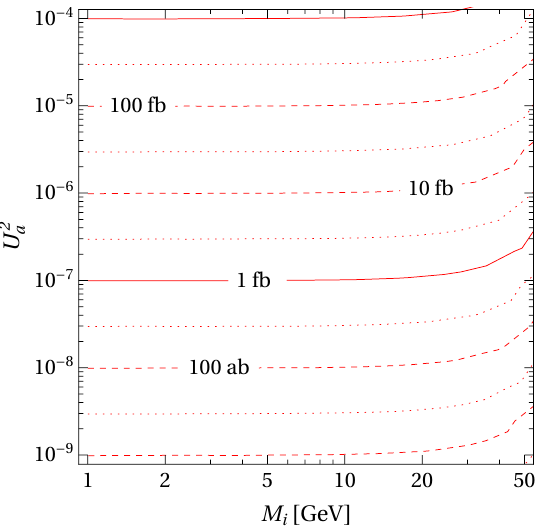
Figure 2. Cross section of the process pp ! l (cid:6) the heavy neutrino mass and its coupling (calculated using MadGraph5 aMC@NLO